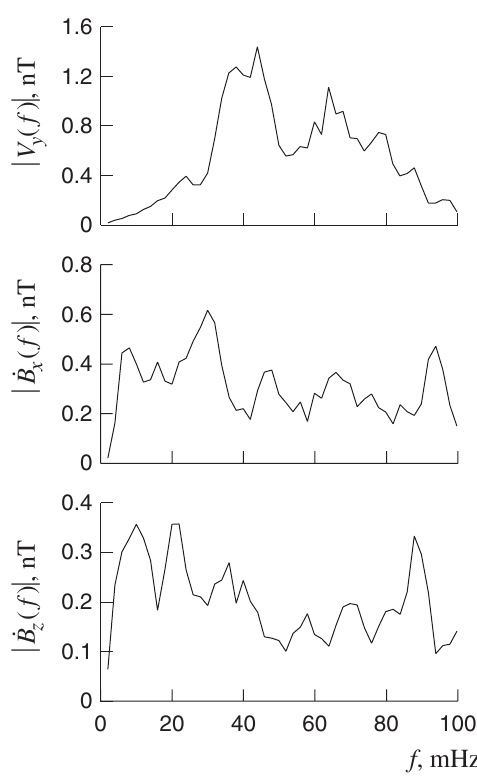
Fig. 3. Spectra of oscillations shown in fig.